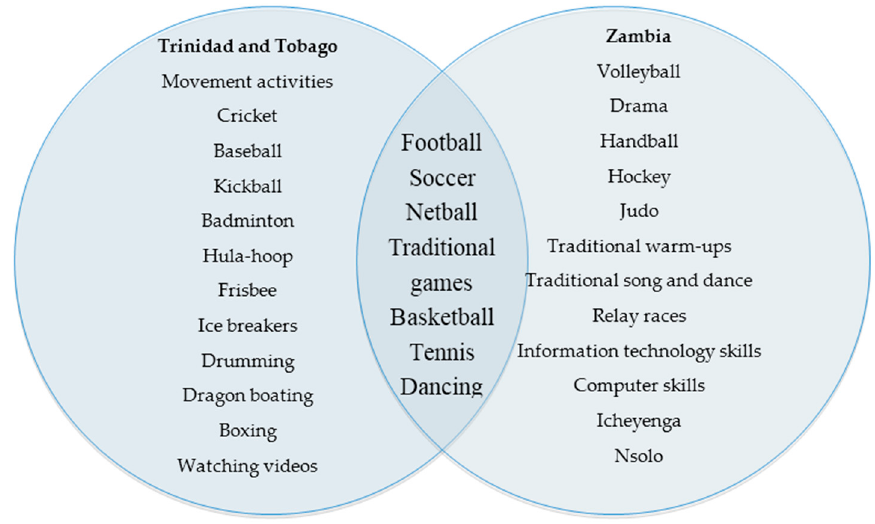
Figure 2. Selected occupations.